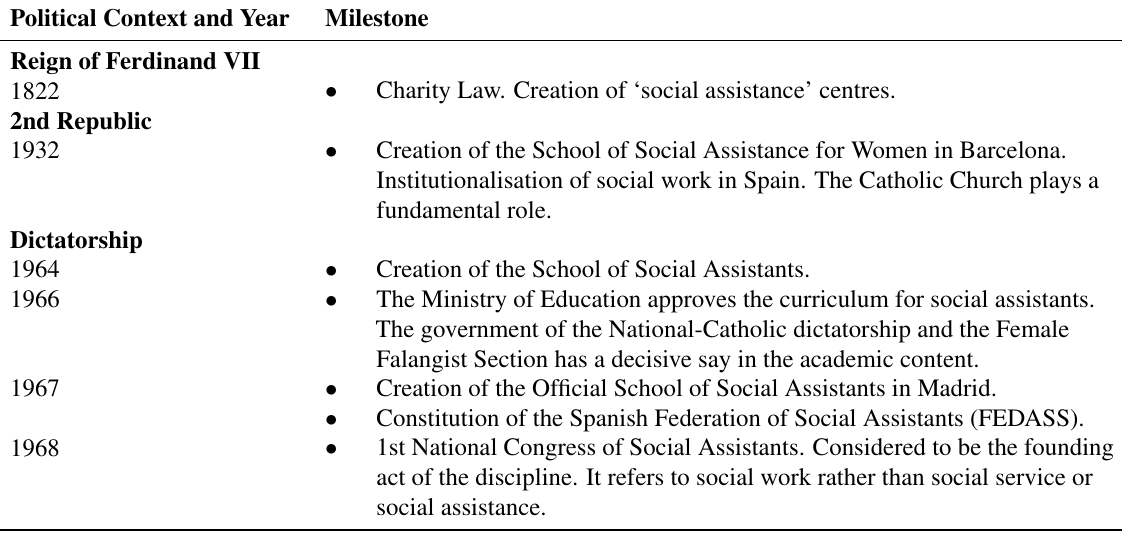
Table 1. Milestones in the history of social work in Spain (Source: Author,